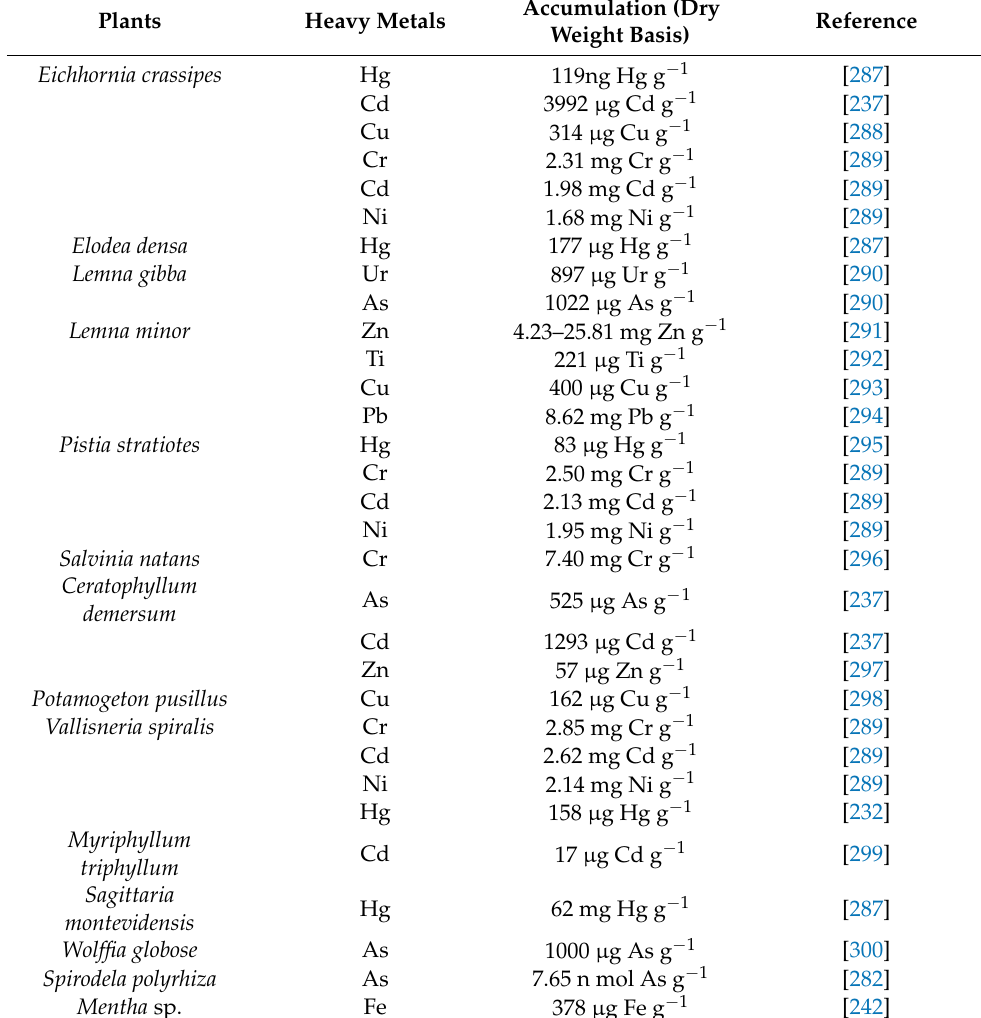
Table 4. Macrophytes recognized for their phytoremediation